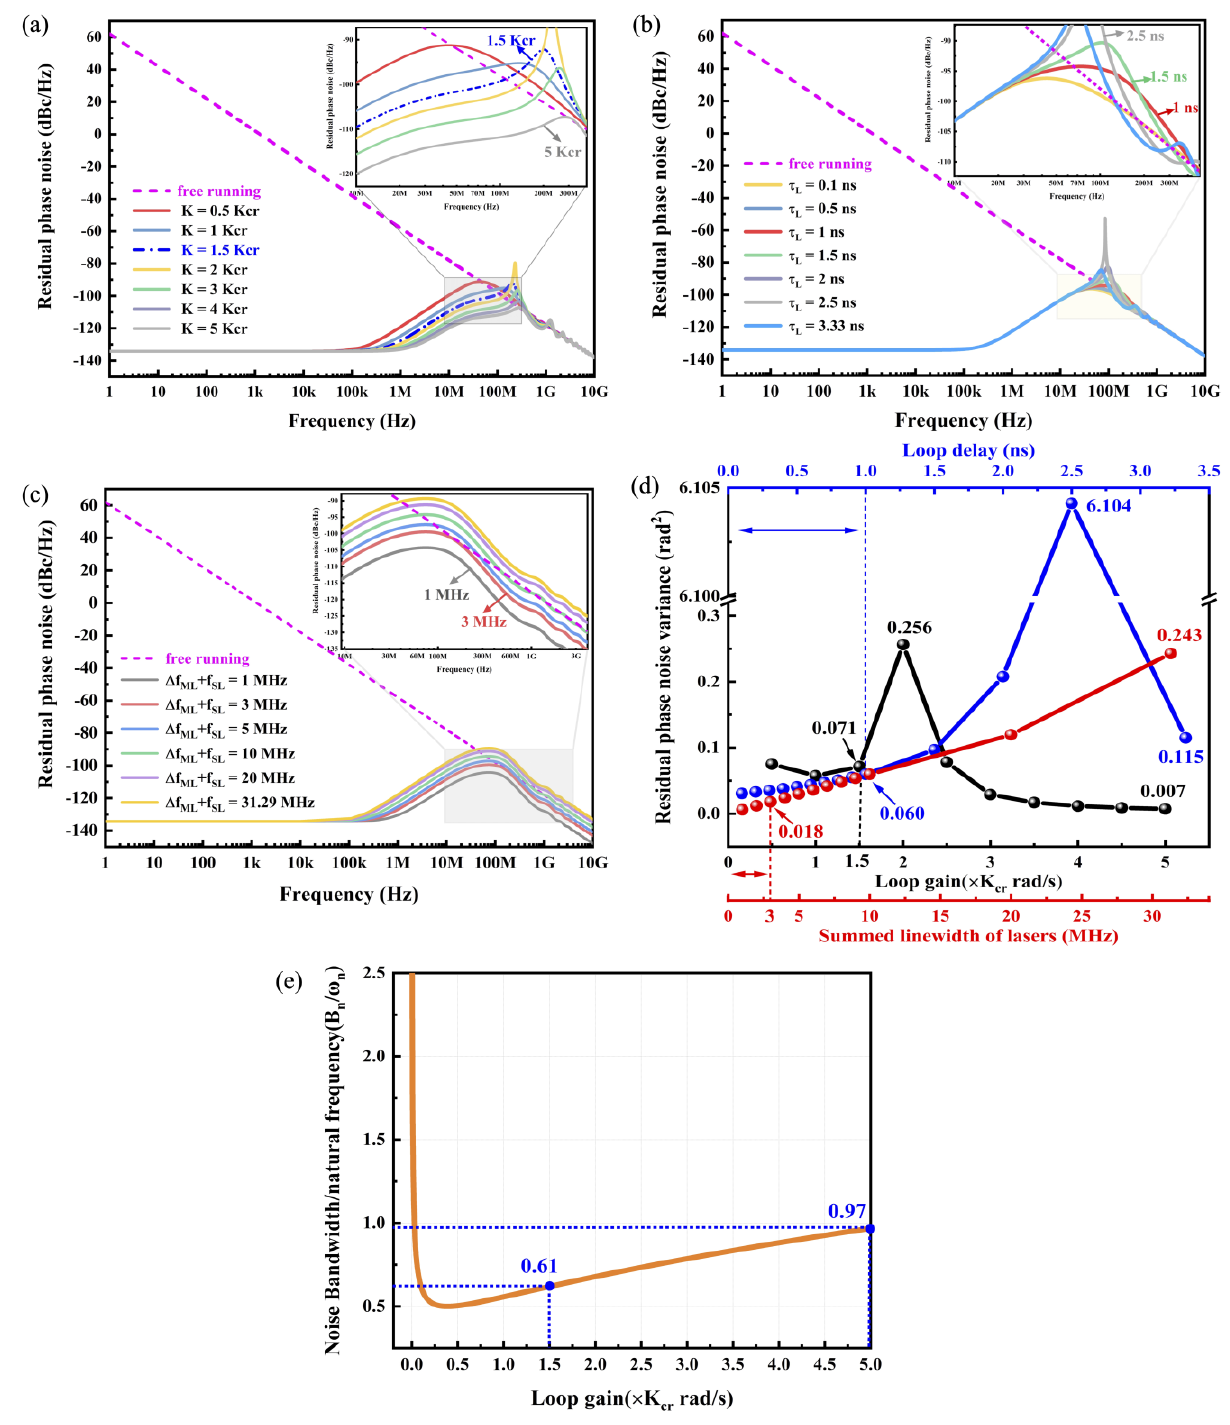
Figure 7. The influences of three parameters on the phase noise characteristics ( a ) loop gain; ( b ) loop delay; ( c ) summed linewidth; ( d ) the dependence of the residual phase noise variance on the loop gain, loop delay, and summed linewidth; ( e ) the relationship between SNR and the loop gain. In addition, Figure 7d also shows the dependence of the residual phase noise vari- ance on the loop delay when the loop gain is 1.5 Kcr. Even though the residual phase noise variance gets worse with the increase in the loop delay up to 2.5 ns, fortunately, such per- formance deterioration is slow before the loop delay reaches 1 ns. Taking into account the effect of the loop delay on the loop bandwidth, as well as on the relaxation oscillation overshooting, we choose 1 ns as the optimal loop delay in our OPLL system, where, the